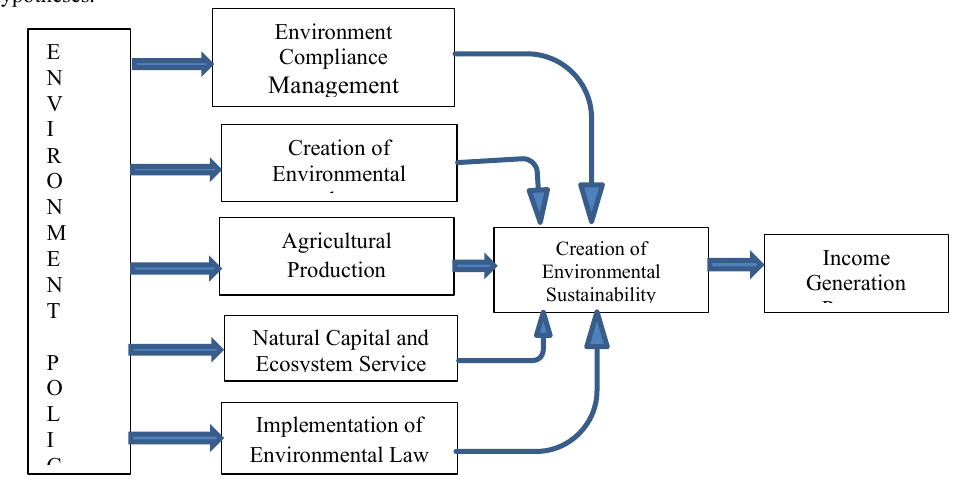
Figure 1 : Research model for environmental policy and income